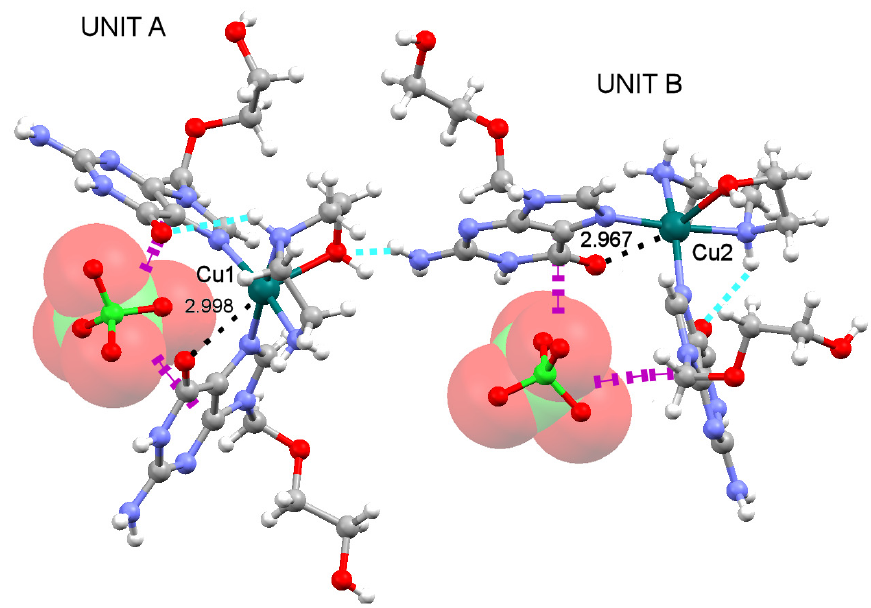
Figure 5. Partial view of the X-ray structure of compound 3 indicating units A and B. Intramolecular H-bonds are depicted as dotted cyan lines. The ancillary Cu ··· O interactions are represented by dashed black lines with their corresponding distance in Å. The perchlorate anions are represented with transparent CPK style with indication of the anion– π interactions (larger magenta horizontal dashed lines). Atoms colour code: carbon—grey; hydrogen—white; nitrogen—blue; oxygen—red; copper—dark green, chlorine—light green.